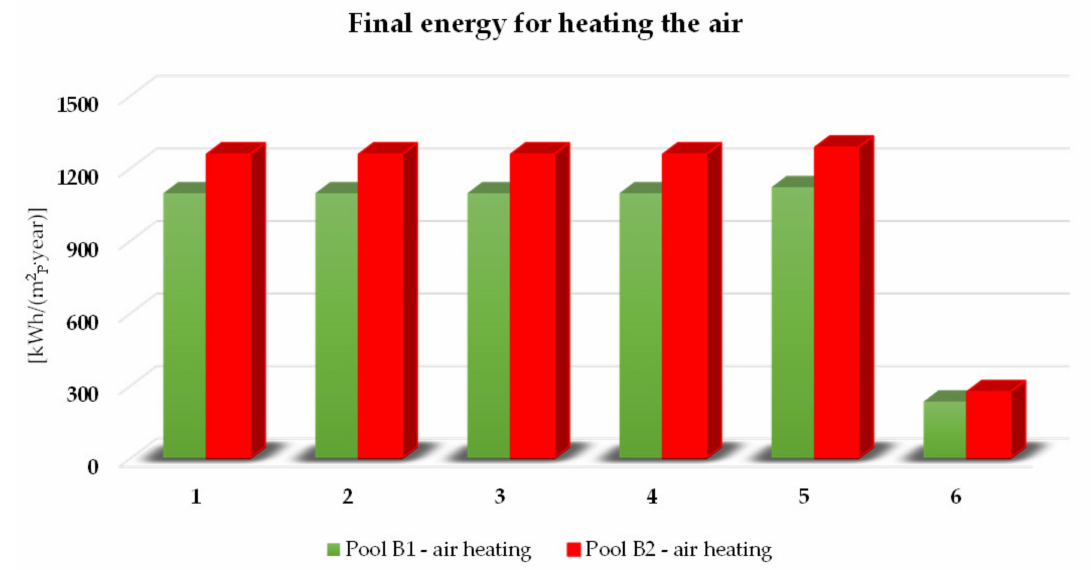
Figure 4. Final energy consumption in the process of heating the ventilation air for the six variants for the sports pool B1 and the recreation pool B2.